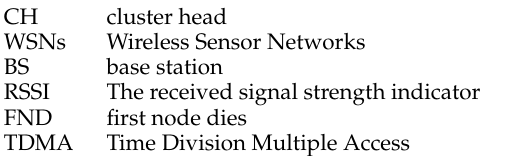
Figure 10. The throughput of the BS when it is outside.